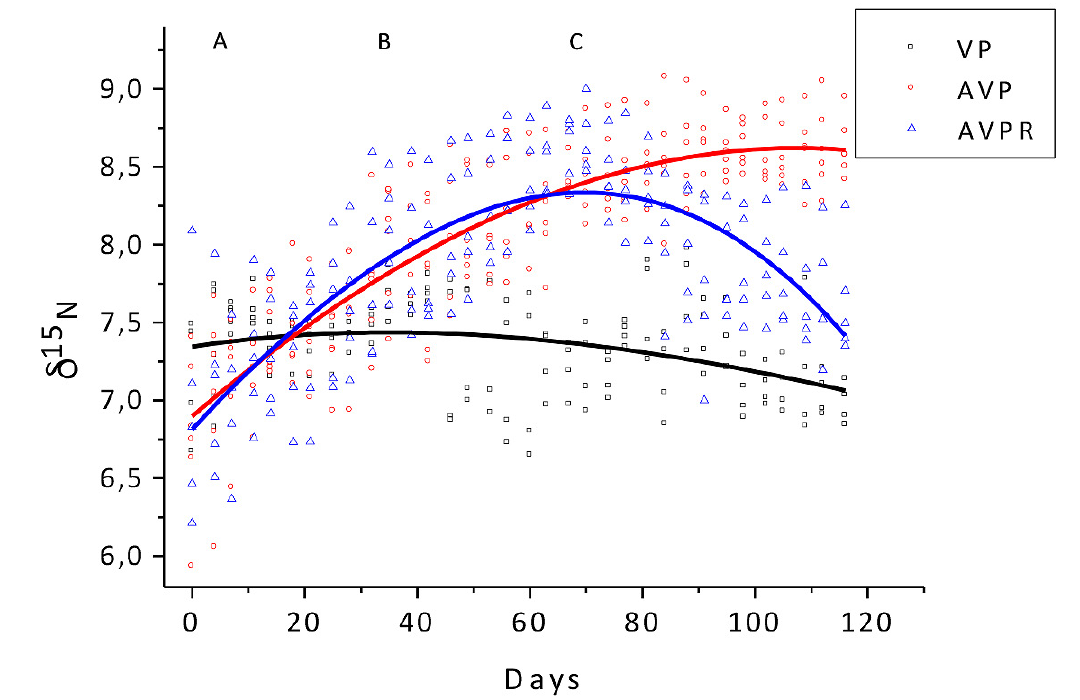
Figure 2. Animal feed δ 15 N measurement. A: adaptation period; B: period in which the AVP and AVPR groups received diet with animal protein; C: period in which the AVPR group received a strictly vegetable